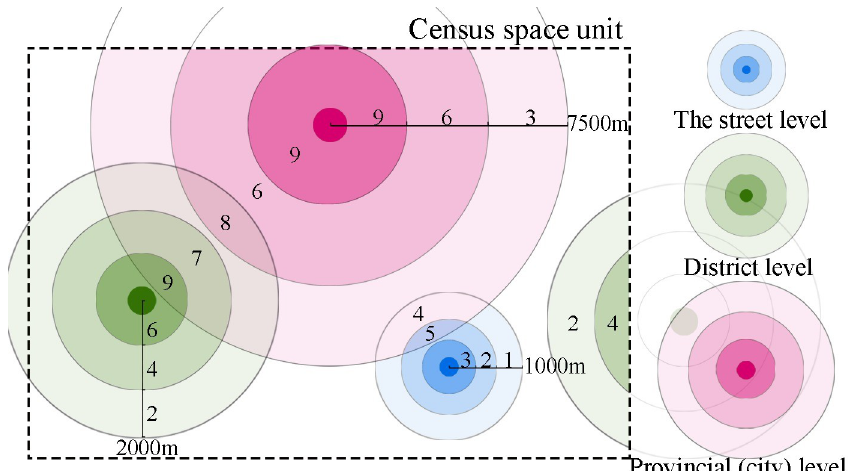
Fig 1. Calculation diagram of effective service area of public sports